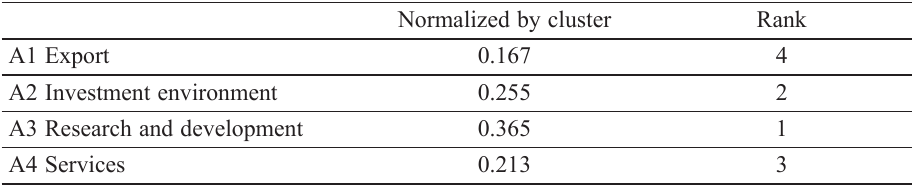
Table 8. Prioritization of the alternatives under opportunity sub-network Normalized by cluster